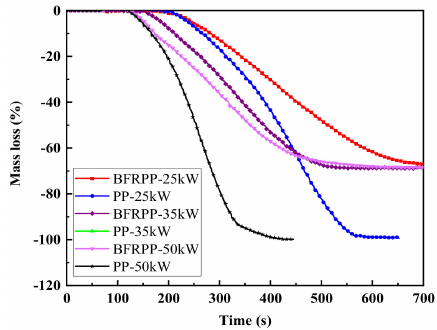
Figure 16. Total mass loss